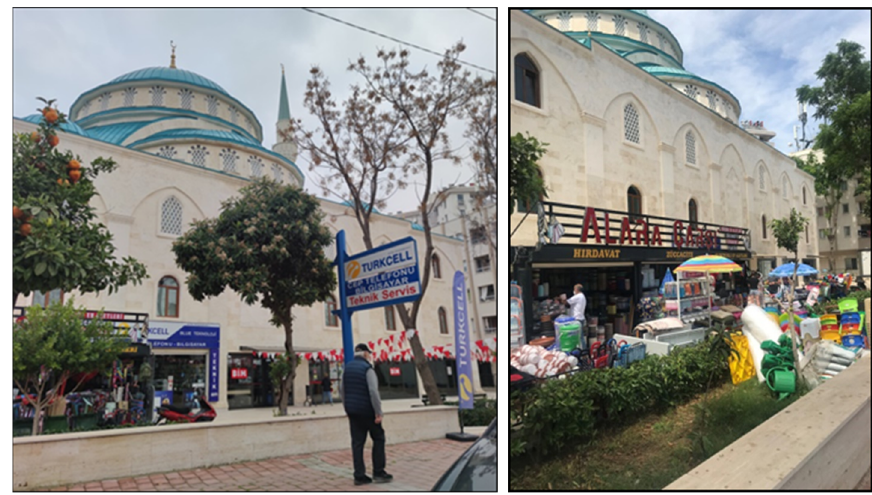
Figure 13. The Guzeloba Mosque’s south façade drawn in the construction permit/south façade in the current use.